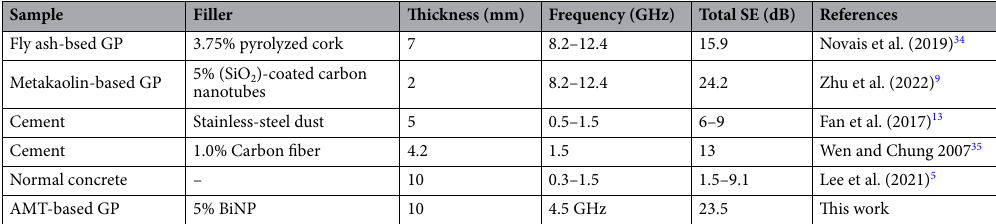
Table 3. Comparison of EMI SE of cement and GP with added filler to the current study.